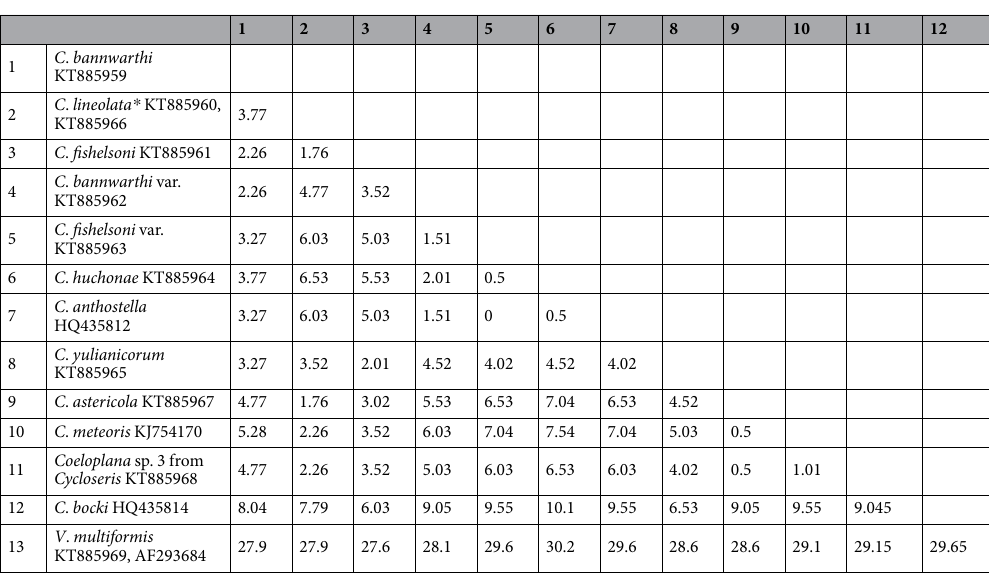
Table 3. ITS1 interspecific sequence divergence ( p -distances) for ctenophores from the family Coeloplanidae. Each species is represented by a single sequence, except V . multiformis and C . lineolata , which are represented by two individuals each. Coeloplana sp. 3 was collected from Cycloseris corals from the Sulu Sea. * C . lineolata and C . punctata were considered to belong to the same